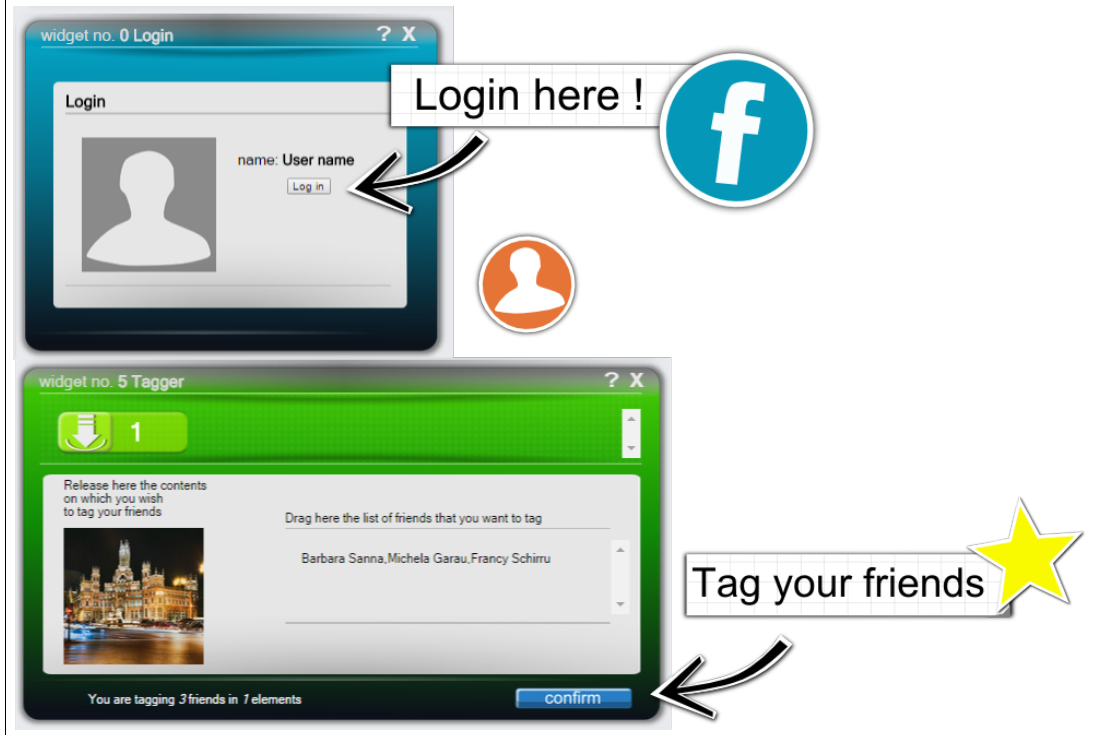
Figure 9. Stickers are used for supporting other SNA users in interacting with the application and makes it more aesthetically